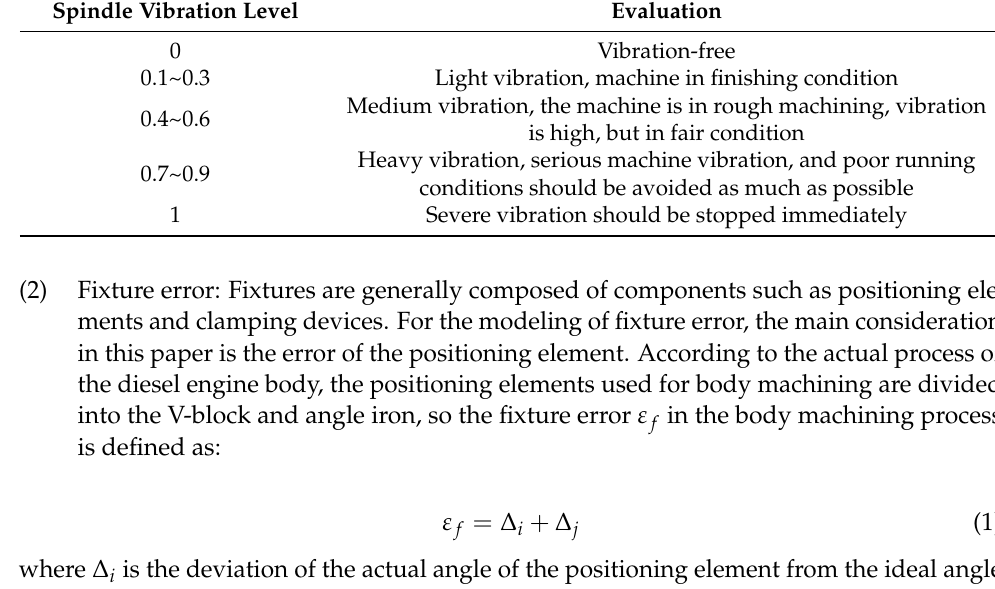
Table 1. Machine tool spindle vibration classification table. Spindle Vibration